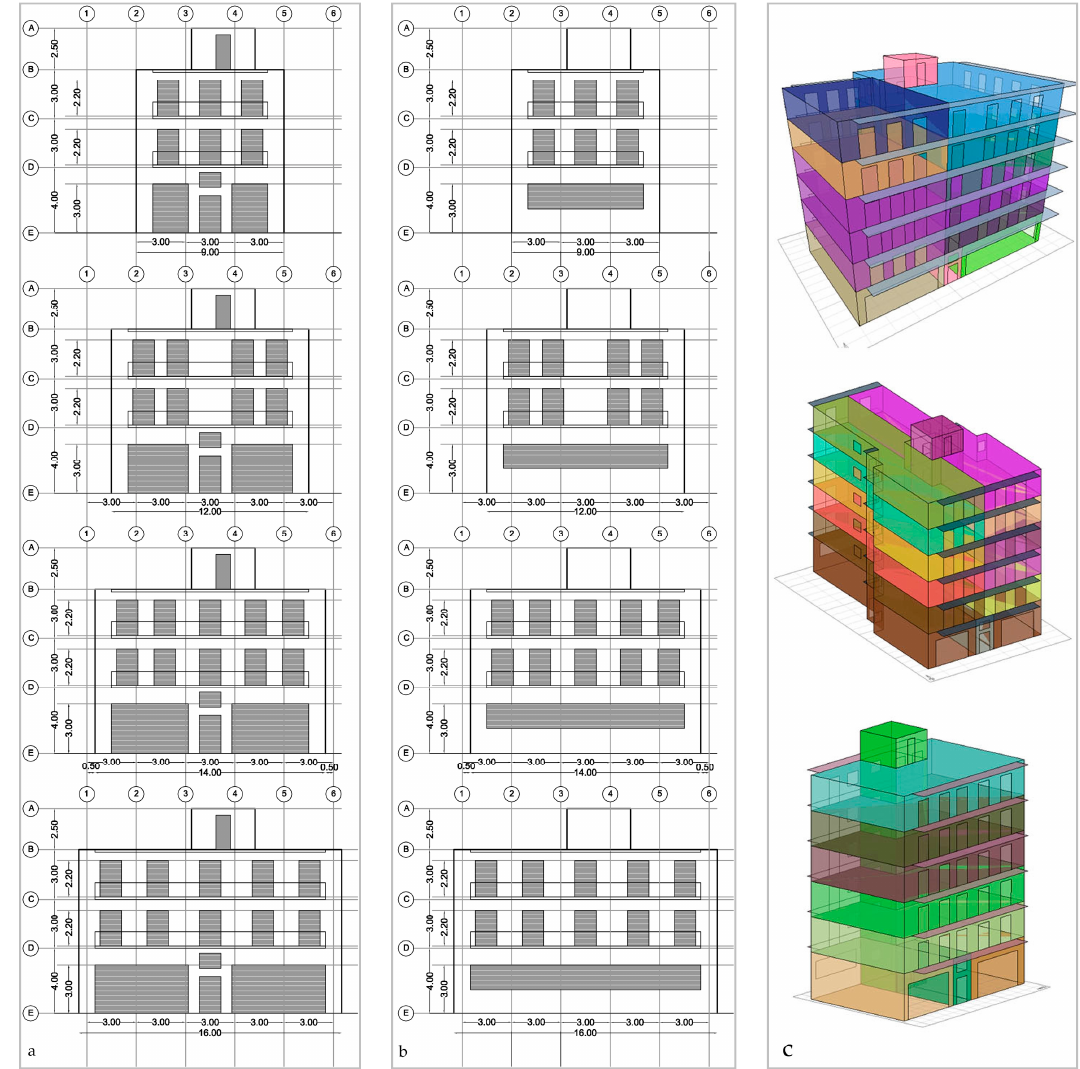
Figure 5. ( a ) Typical configuration of buildings front (street) façade; ( b ) Typical configuration of buildings rear façade; ( c ) 3D model of three typical building blocks used for design of urban blocks [37].